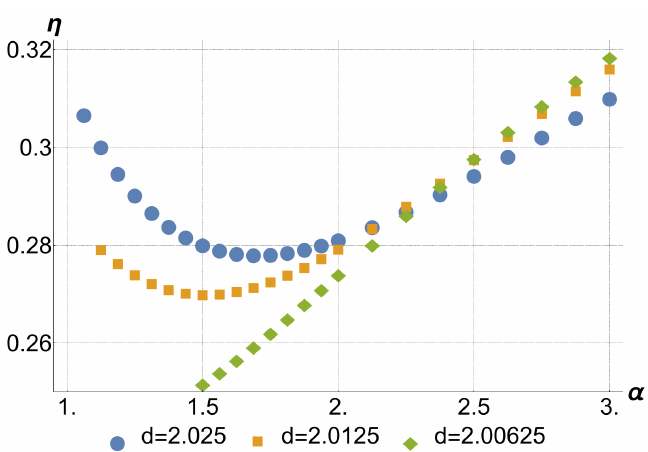
Figure 4: (Color online) Variation of η depending on α for a sequence of dimen- sionalities in close vicinity of 2 and N = 2. No PMS value is found for d sufficiently low.